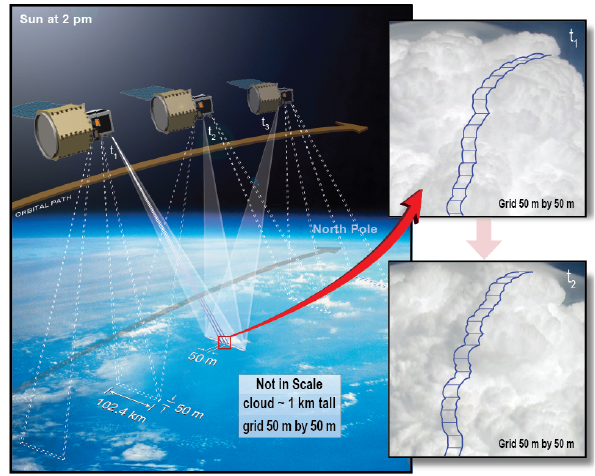
Fig. 1. An illustration of the measured vertical profiles of cloud pa- rameters pointing 30 ◦ off track toward sun-illuminated cloud sur-